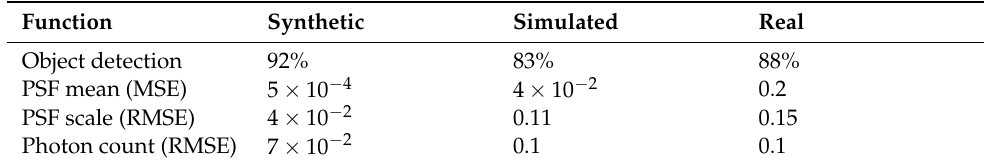
Table 1. CNN accuracy results after 50 epochs against three data sets.